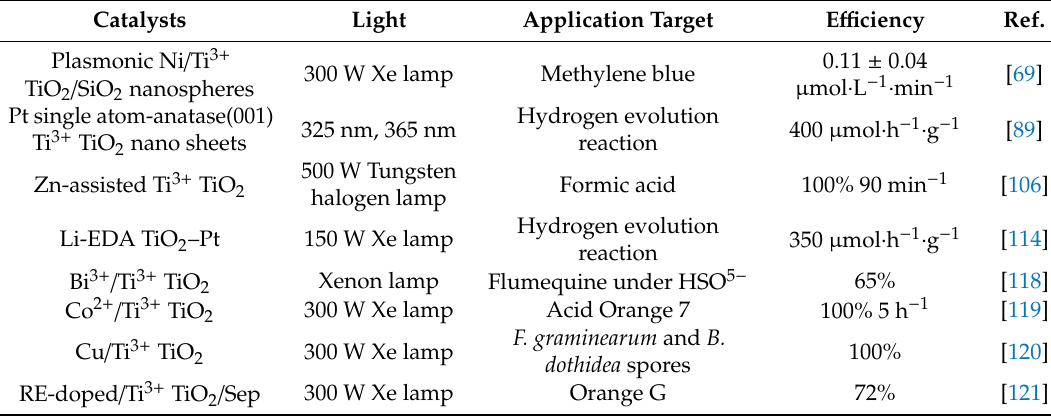
Table 1. Summary of metal-doped Ti 3 + self-doped TiO 2